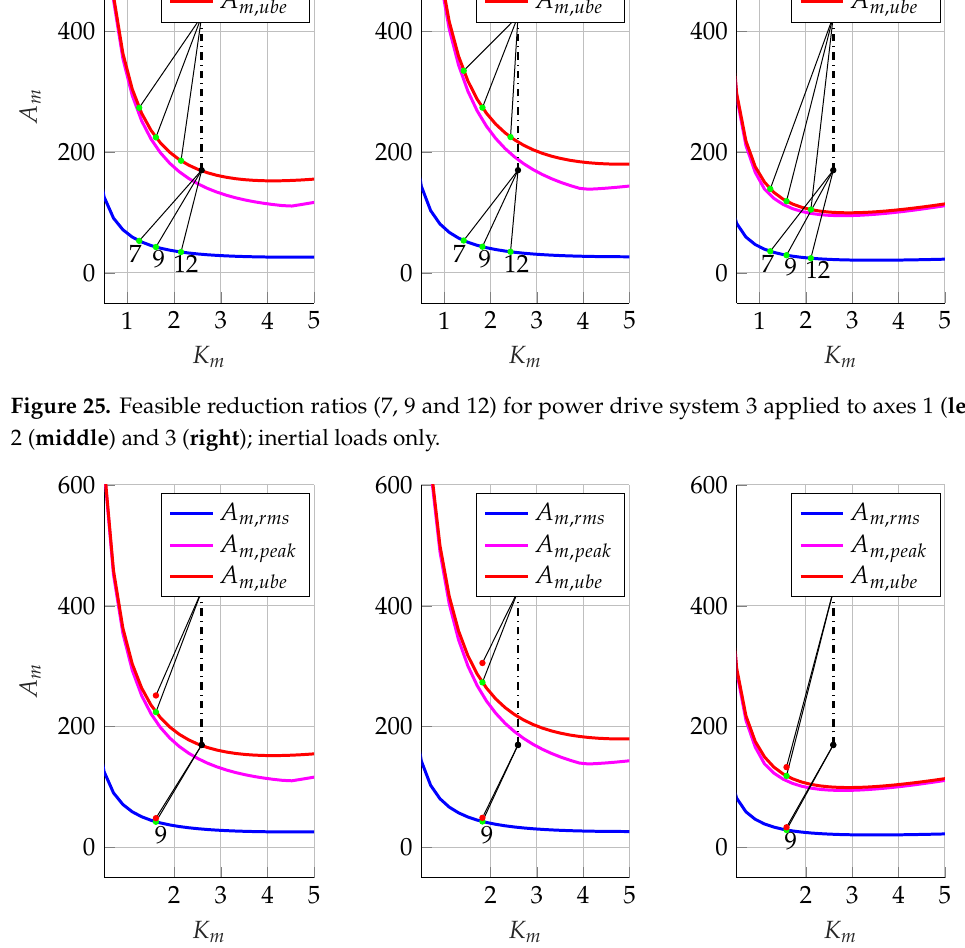
Figure 26. Comparison (for axes 1,2 and 3 from left to right ) between an ideal and a non-ideal transmission having reduction ratio i t = 9; inertial loads only. The green points correspond to the ideal transmission, while the red ones to the non-ideal